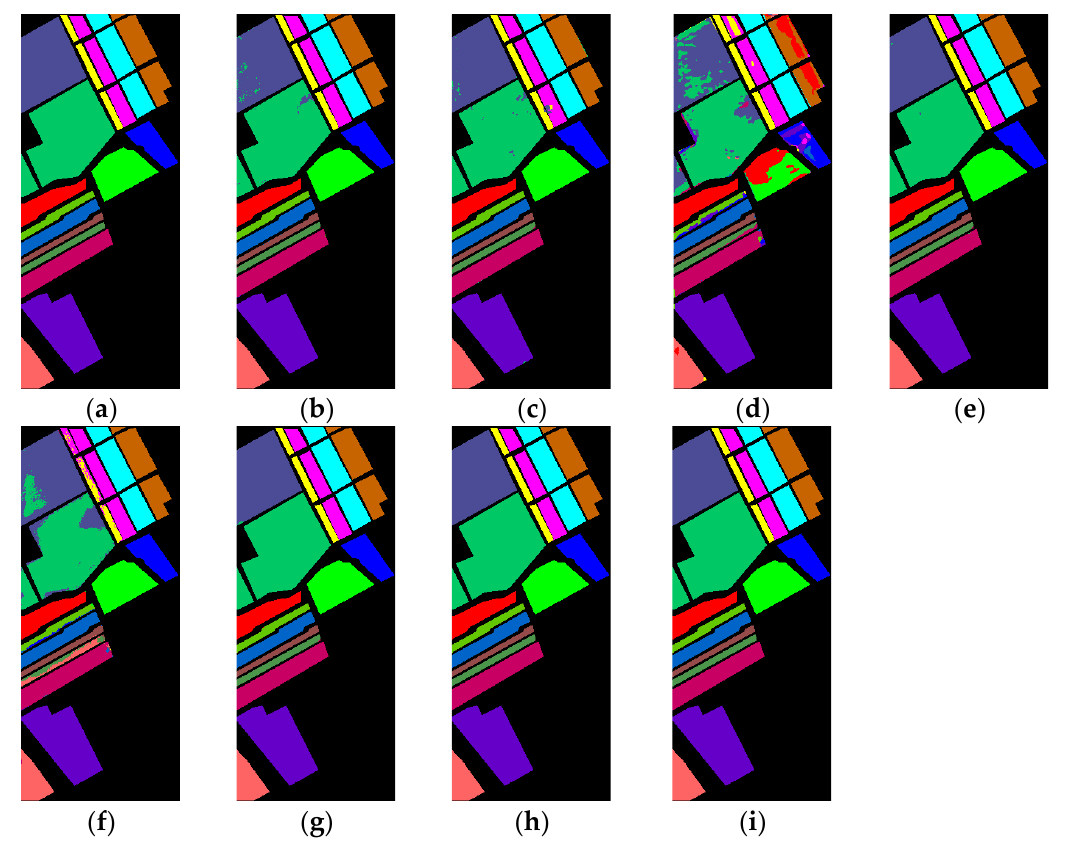
Figure 10. Classification maps generated by all of the competing methods on the Salinas Scene data with 5% training samples; ( a ) is ground truth map, and ( b – i ) are the results of Baseline, 3DCNN, SSRN, HybridSN, ViT, 3D_Octave, OctaveVit, and SATNet, respectively.